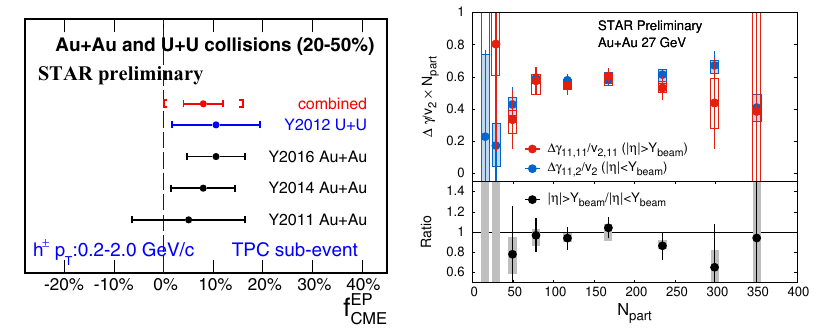
Figure 1. (Left) The fraction of the possible CME signal( f CME ) in ∆ γ with respect to TPC and ZDC event planes for Au + Au collision at 200 GeV and U + U collision at 193 GeV, combined result shows 8 4 8%. (Right) ∆ γ scaled by v 2 with respect to TPC-EPD-inner and TPC-EPD-outer planes to the ± ± no-CME scenario for Au + Au collision at 27